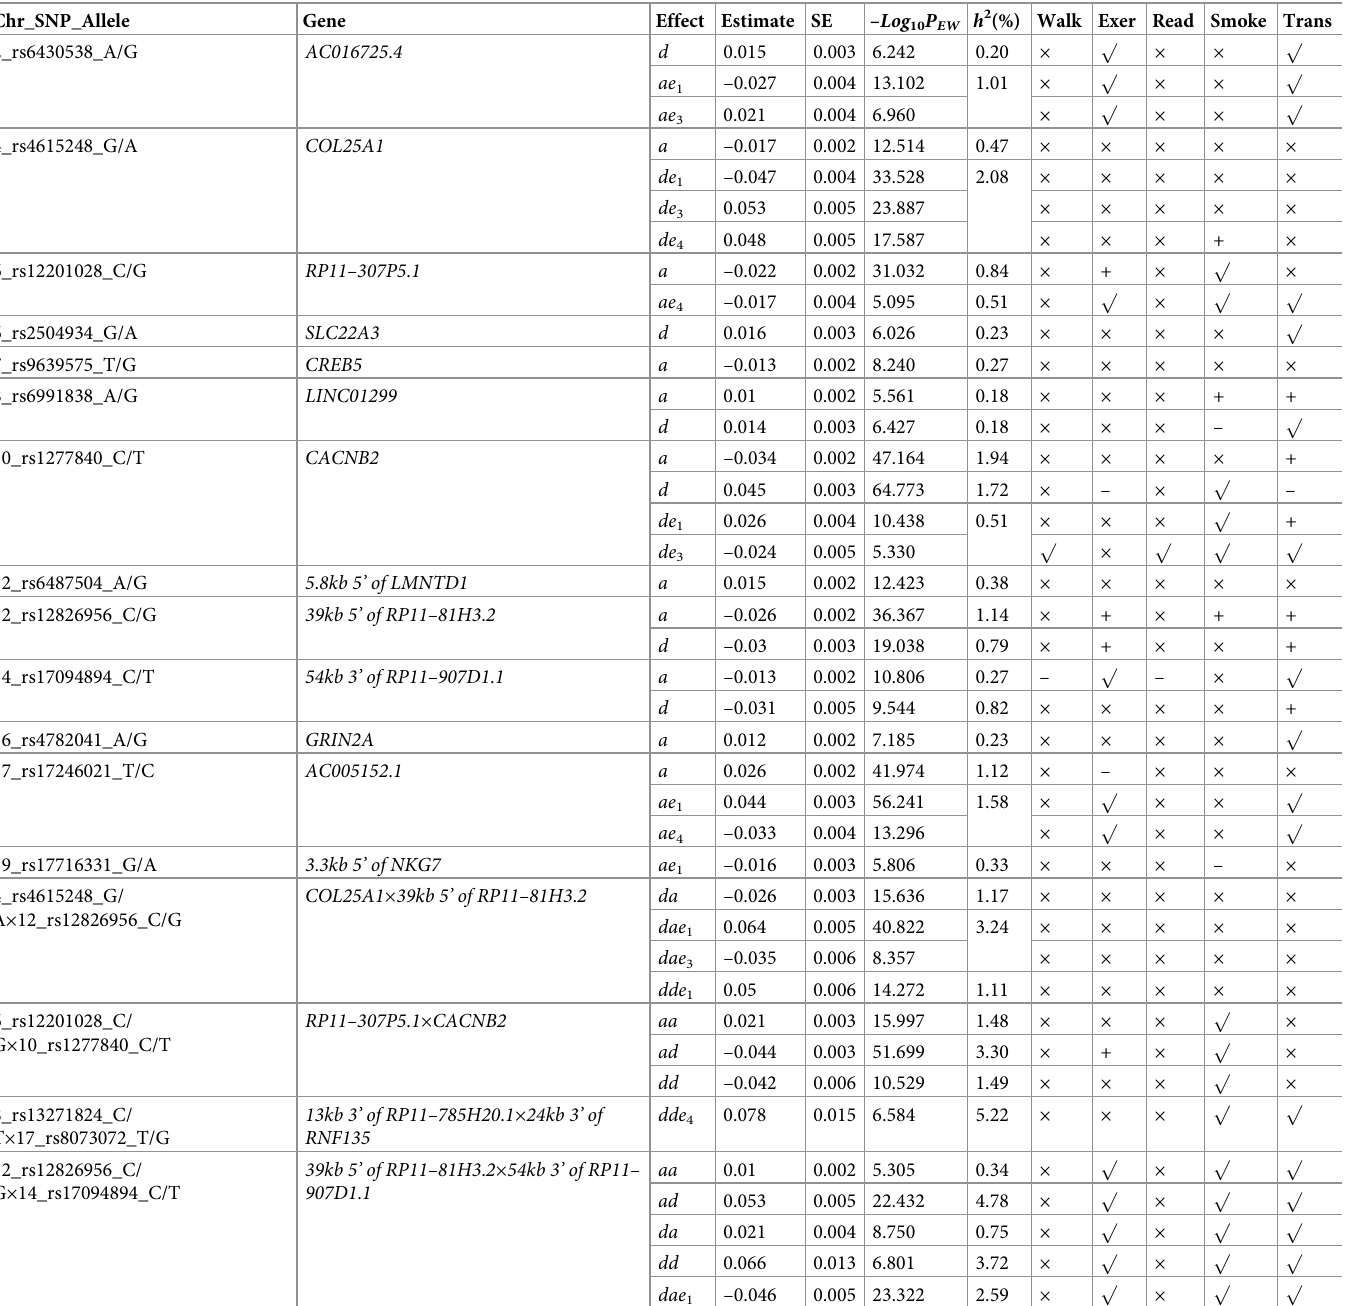
Table 2. Predicted genetic effects of individual and epistasis loci with standard error, significance, and heritability for body surface area in the base